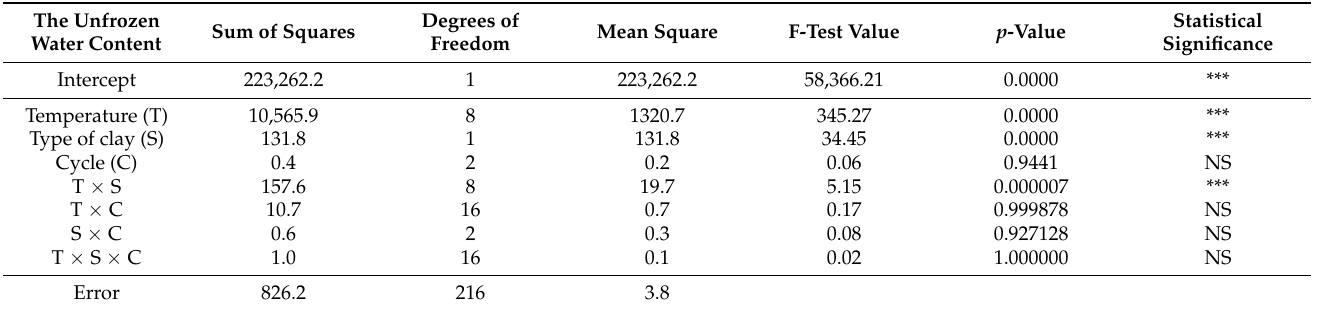
Table 4. Univariate tests of the significance of the temperature and its interaction with the clay, copper concentration, and cycle for the unfrozen water